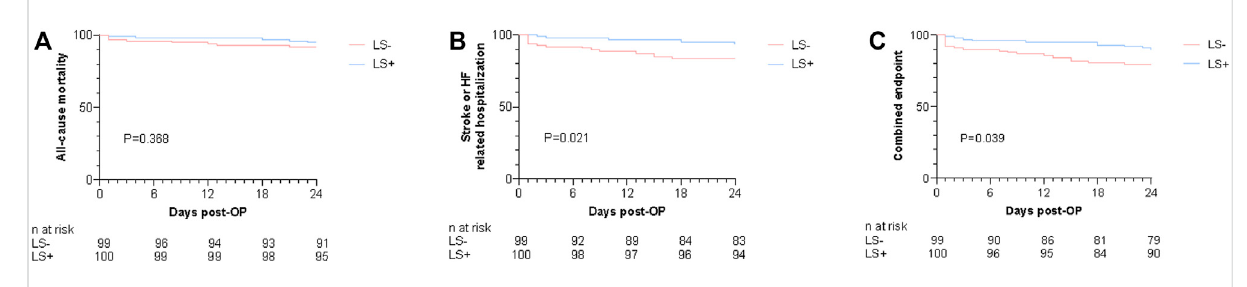
FIGURE 2 Kaplan-Meier estimates for the cumulative events rates of 2-year all-cause mortality (A) , 2-year stroke or HF-related hospitalization (B) , and combined endpoint (C) . p value from log-rank chi-square test. OP, operation; HF, Heart failure; Levosimendan group; LS-, Control group.